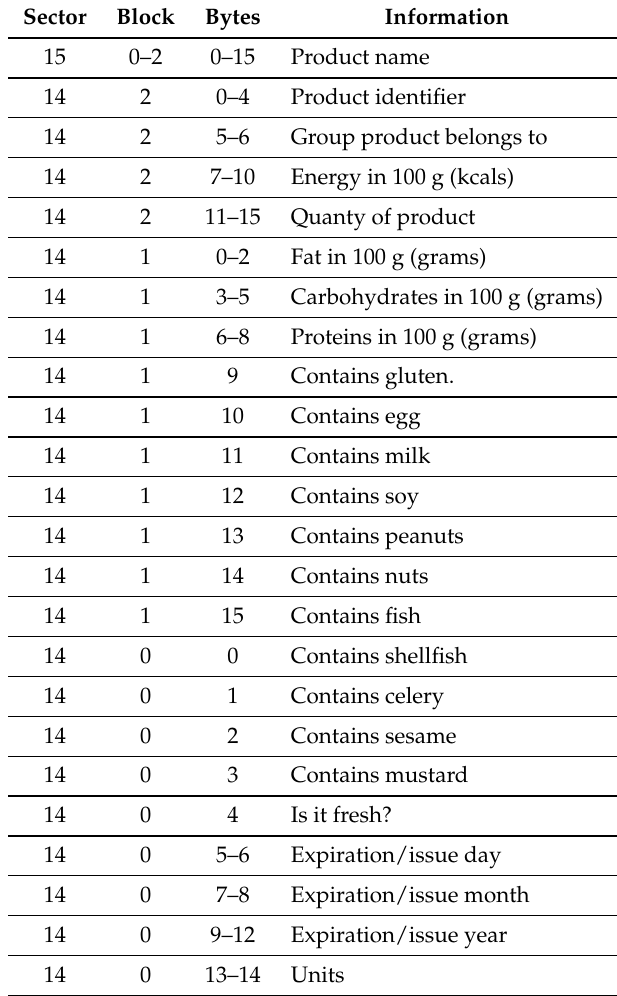
Table 2. Bytes used to locate product